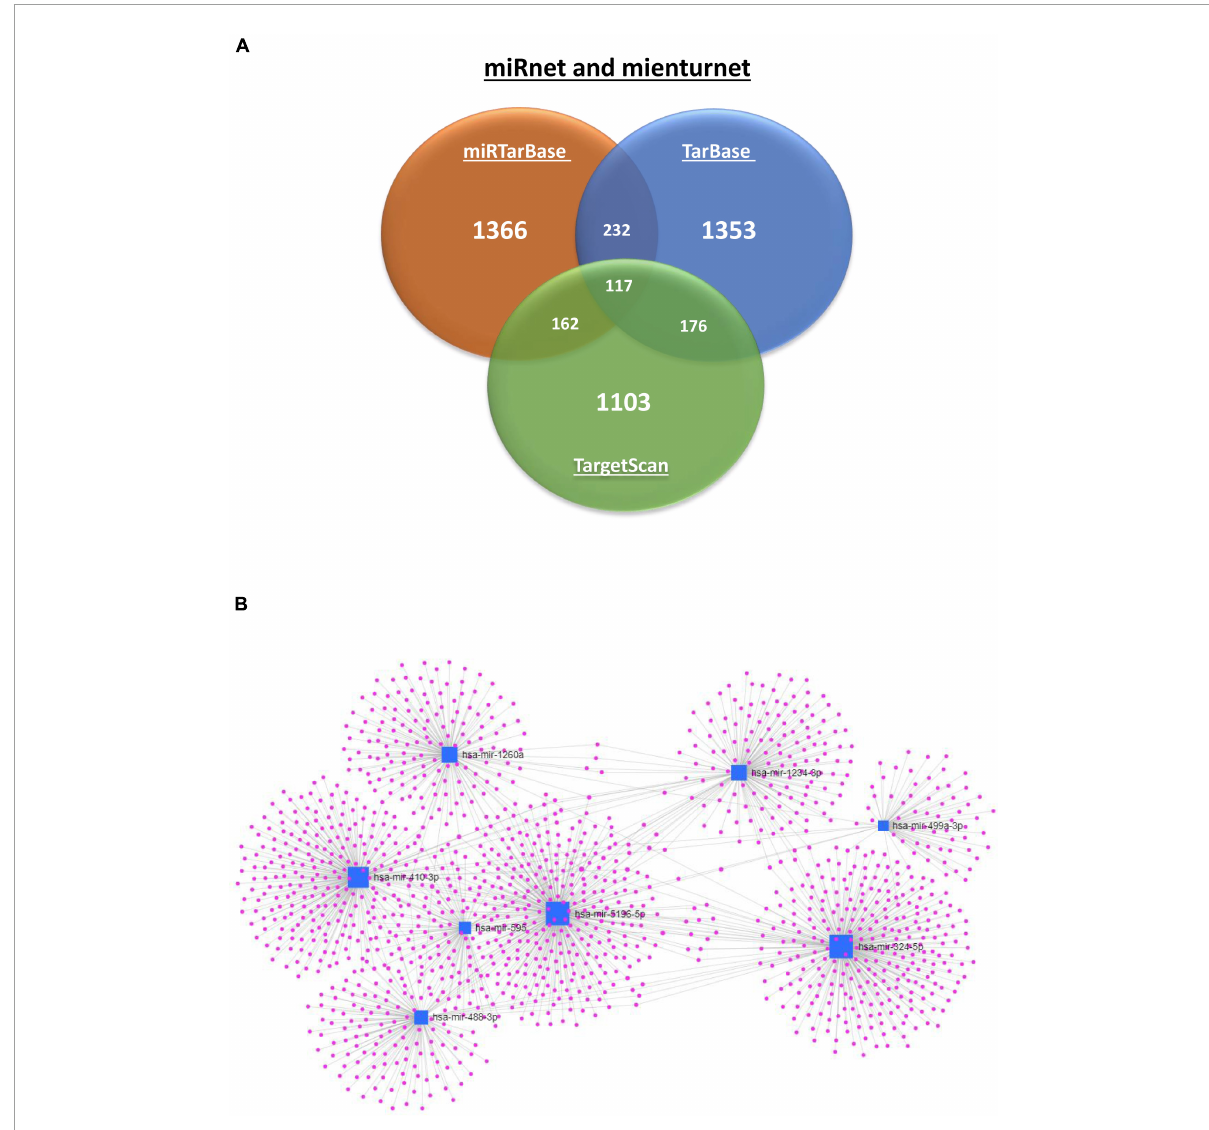
FIGURE4 Interaction of 9 miRNA differentially expressed according to DCI occurrence with genes. (A) Venn diagram of predicted and validated number of interactions of miRNA with genes by miRTarBase (Orange), TarBase (blue), and TargetScan (green) databases. (B) Network analysis was performed with target genes of selected miRNAs of the DCI comparison using miRTarBase database. The miRNAs are represented by a blue nodule and the genes that interact with the miRNAs in purple. The gene interaction is represented by a blue